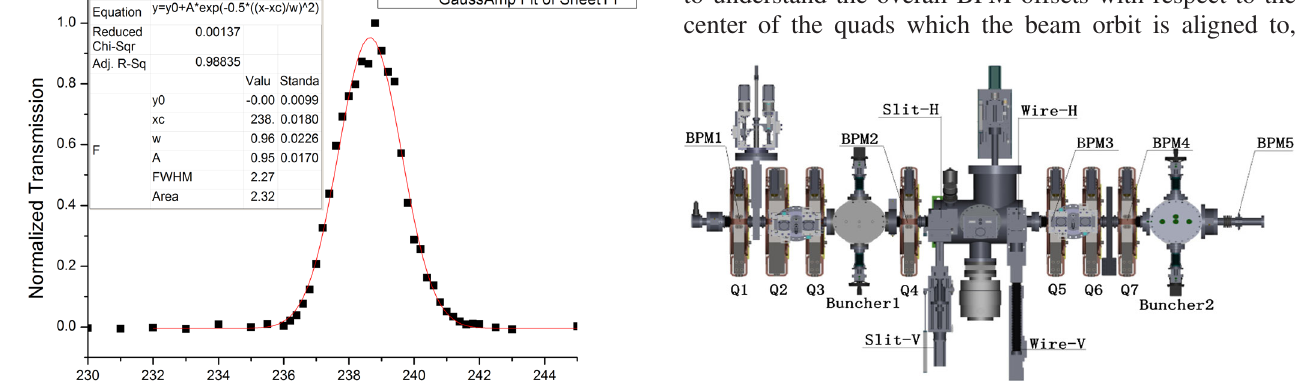
FIG. 12. The layout of the MEBT and beam diagnostics